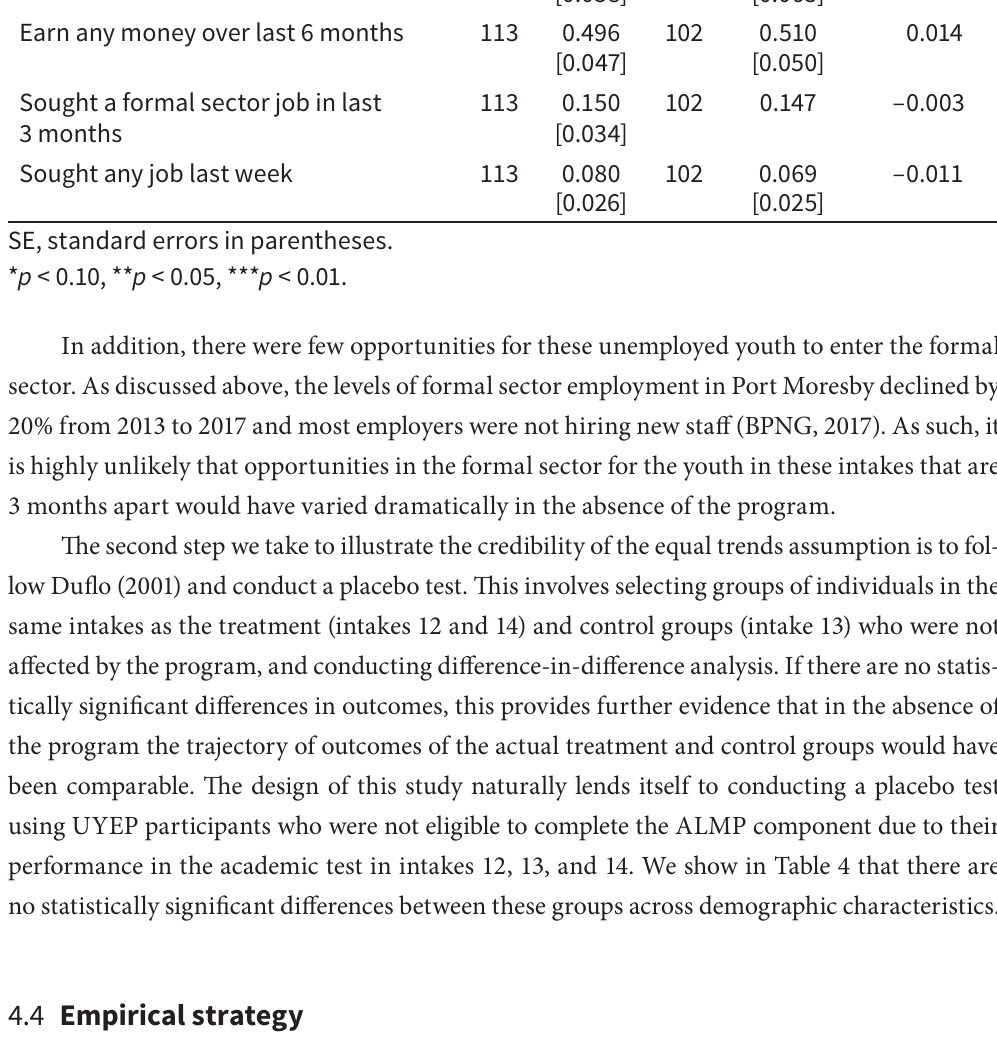
Statistical balance across employment and job-seeking histories (1) (2) t -test Control (2) - (1)